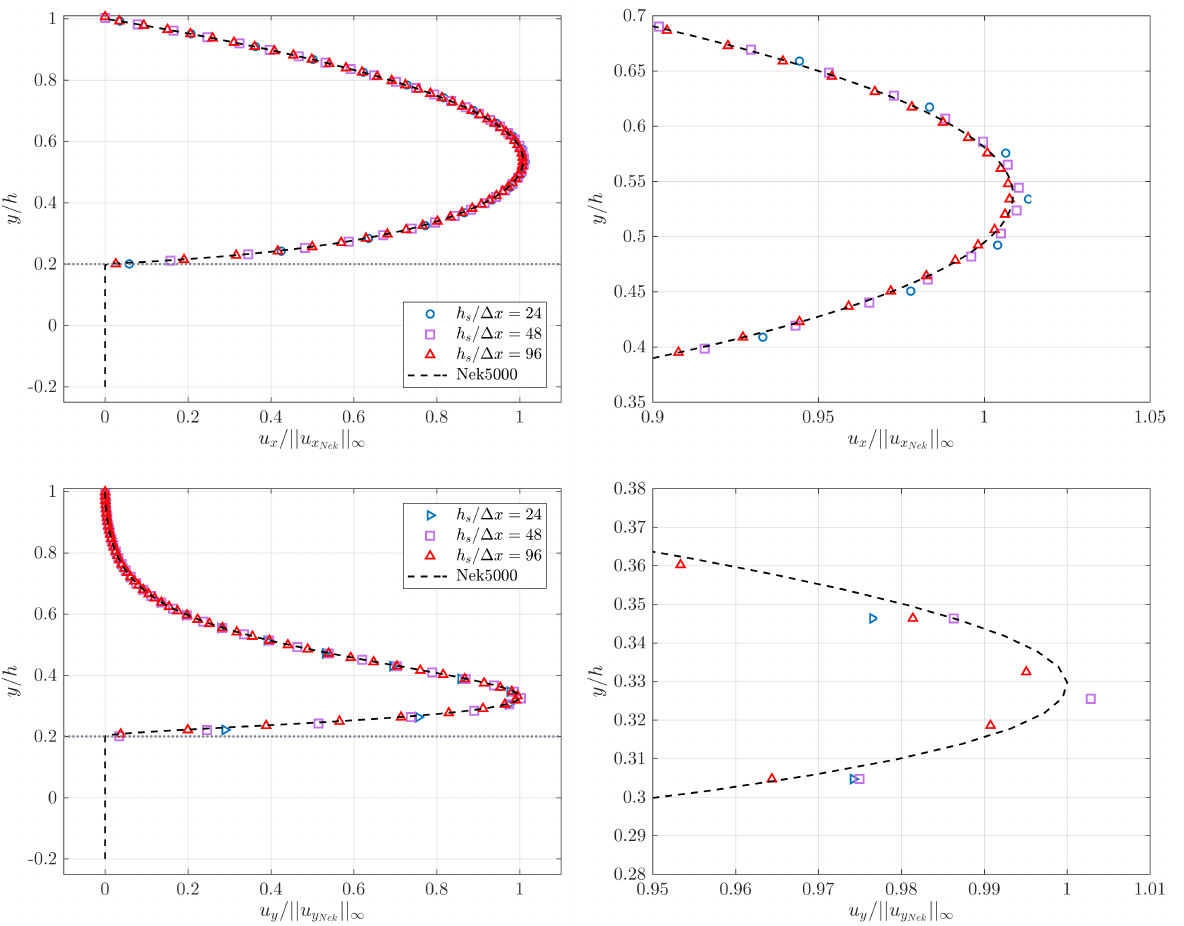
Figure 16. Profiles of u x , u y and u z for h / ∆ x = 24,48,96 along the wall-normal direction, profile set at ( x 1 , z 1 )